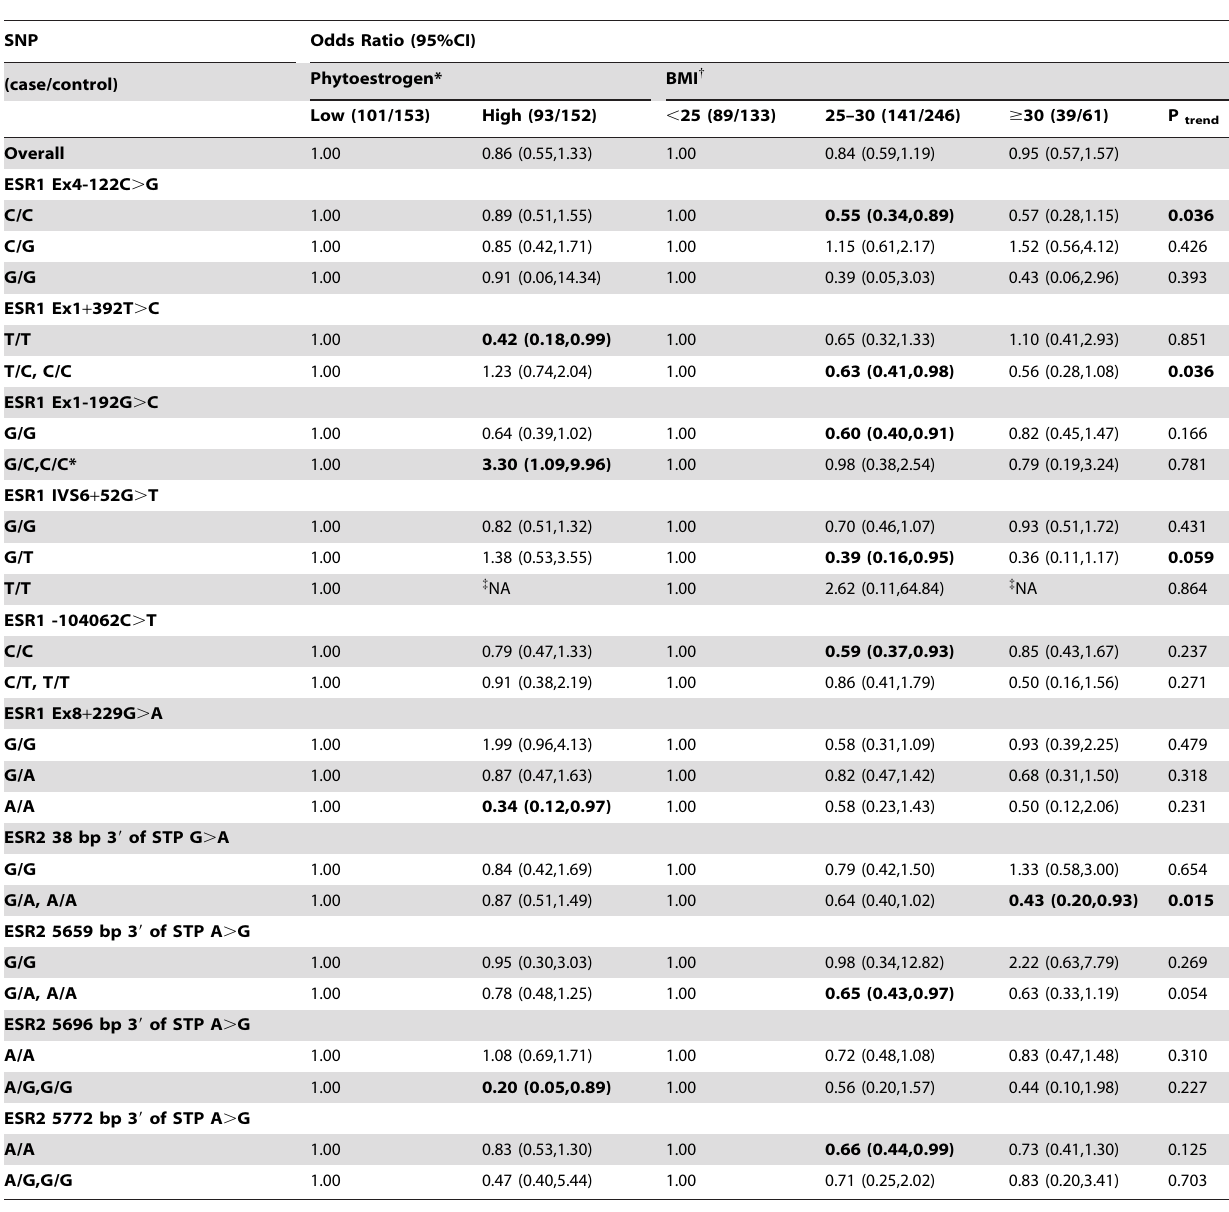
Table 4. The effect of phytoestrogen* and BMI on the risk of prostate cancer by the genotypes of estrogen receptor gene SNPs.